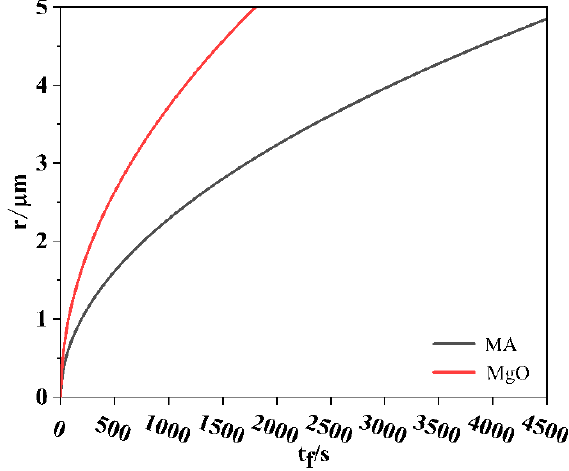
Figure 12. Complete modification time of Al 2 O 3 inclusions with different sizes.